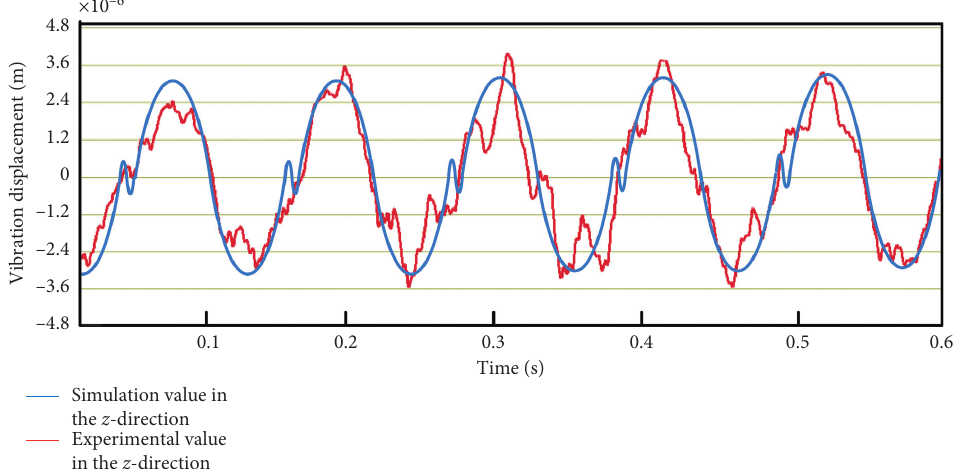
Figure 16: Comparison of experimental values and simulated values of axial vibration displacement at